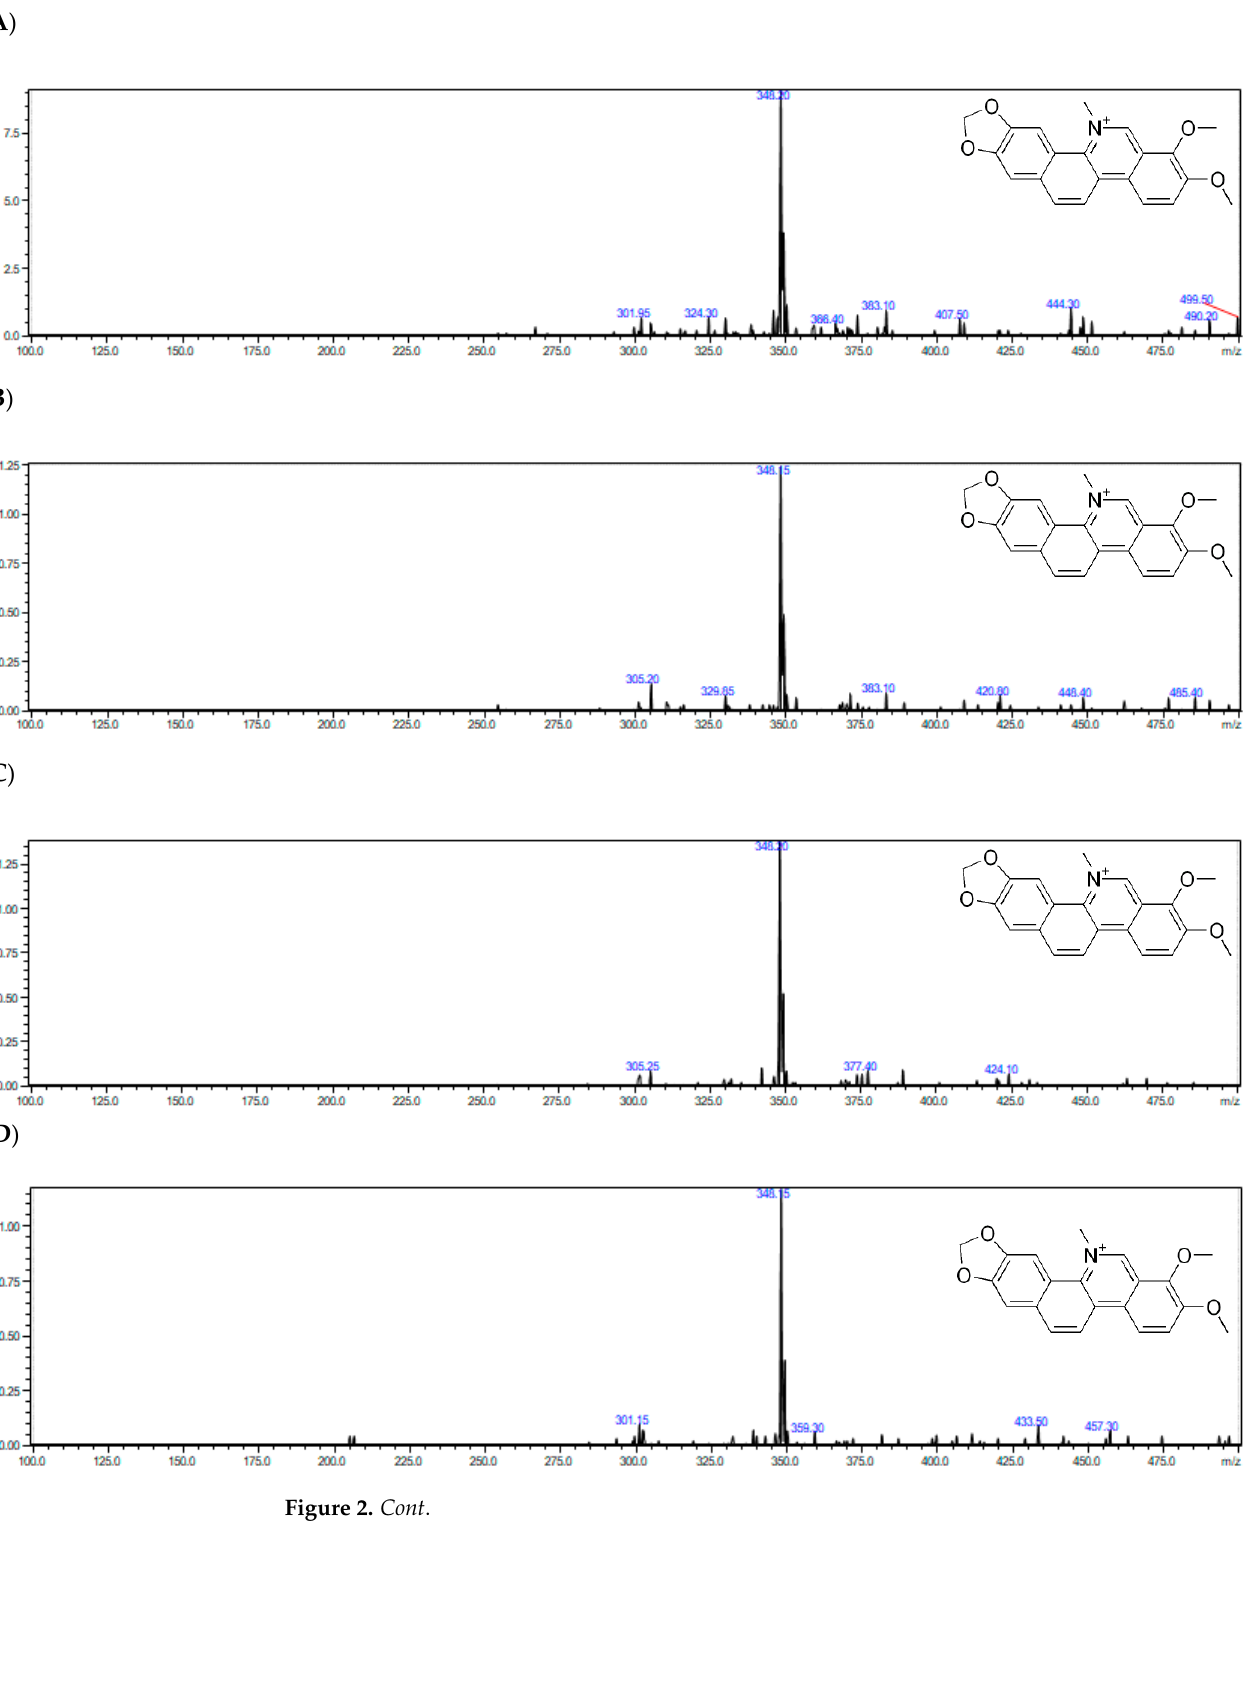
Figure 2. Representative full-scan MS spectra obtained with the use of ESI–Q-TOF–MS/MS for chelerythrine from the Macleaya cordata ’s extracts: ( a ) aerial part collected in May, ( b ) root collected in May, ( c ) aerial part collected in July, ( d ) root collected in July, as well as representative product ion MS/MS spectra obtained with the use of ESI-Q-TOF-MS/MS for chelerythrine ( e ), protopine ( f ), and sanguinarine ( g ) from the Macleaya cordata extracts. 2.3. Optimization of Cholinesterase Activity Determination